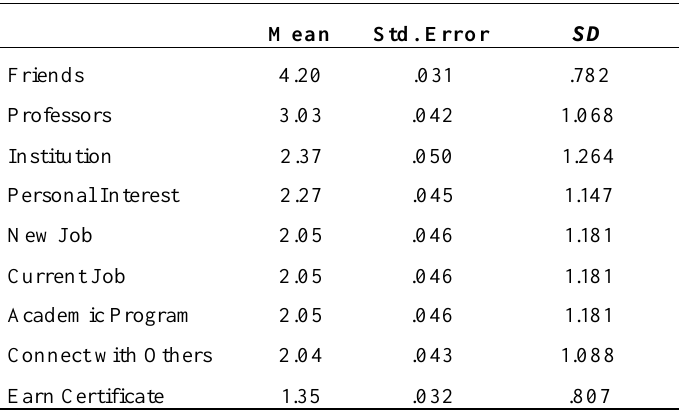
The Importance of Motivation Factors for Enrolling in